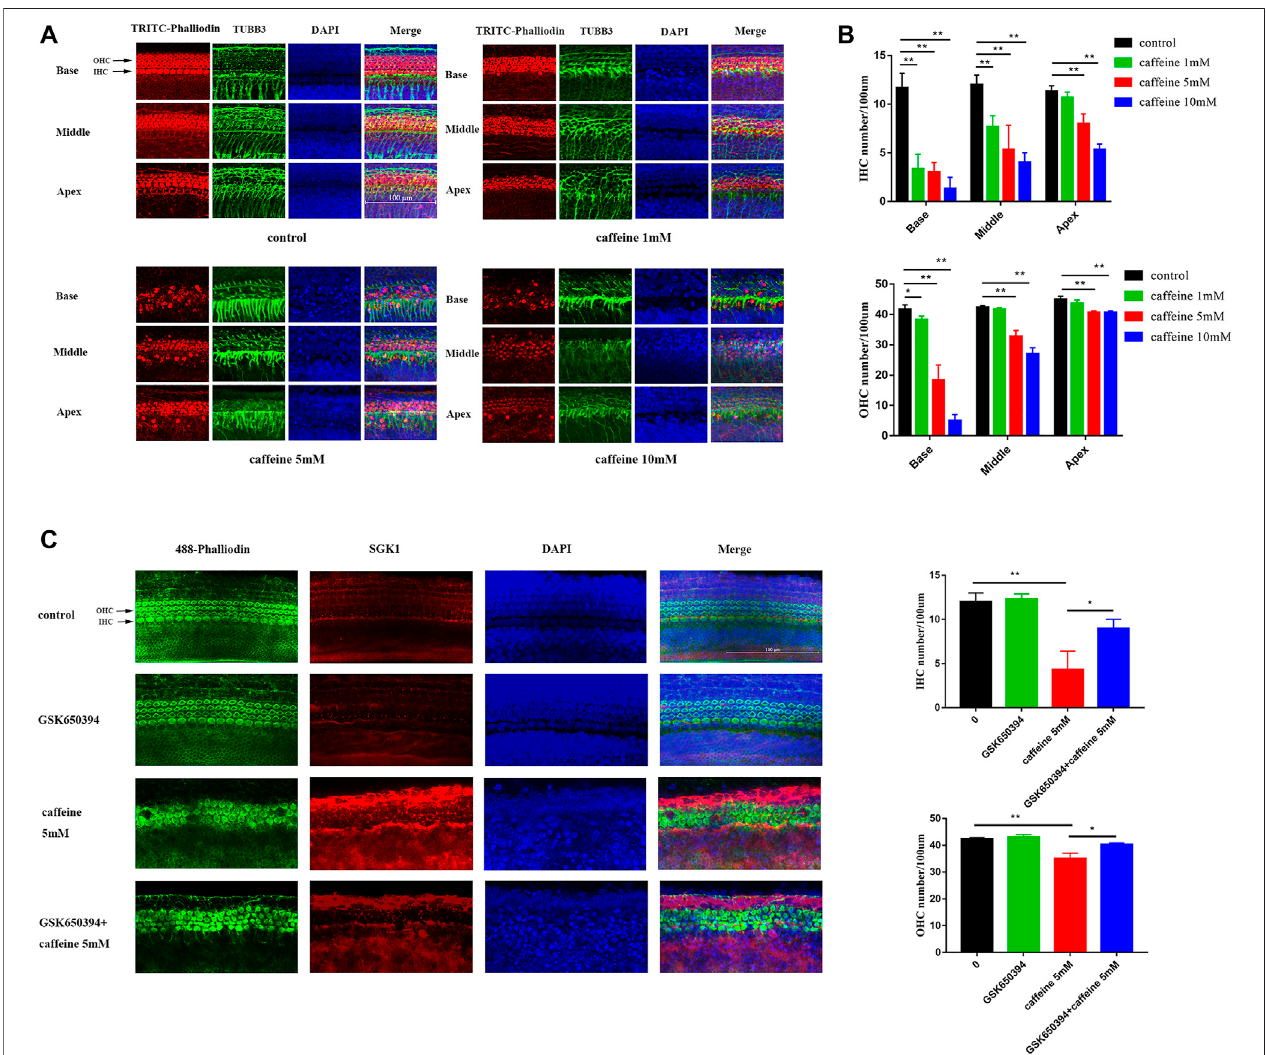
FIGURE 6 | Caffeine activates SGK1 to destroy hair cells and nerve fi bers in P3 SD rats. (A – B) The basilar membranes of SD newborn mouse were stained with fl uorescent phalloidin(red)andTUBB3(green).DAPI(blue)wasusedtostainthenuclei.Scalebar:100 μ m.Dataareshown asmeans ± SD, **p < 0.01,*p < 0.05 . (C – D) The middle turn of basilar membranes was stained with fl uorescent phalloidin (green) and SGK1 (red). DAPI (blue) was used to stain the nuclei. Scale bar: 100 μ m. Data are shown as means ± SD, **p < 0.01, *p < 0.05.